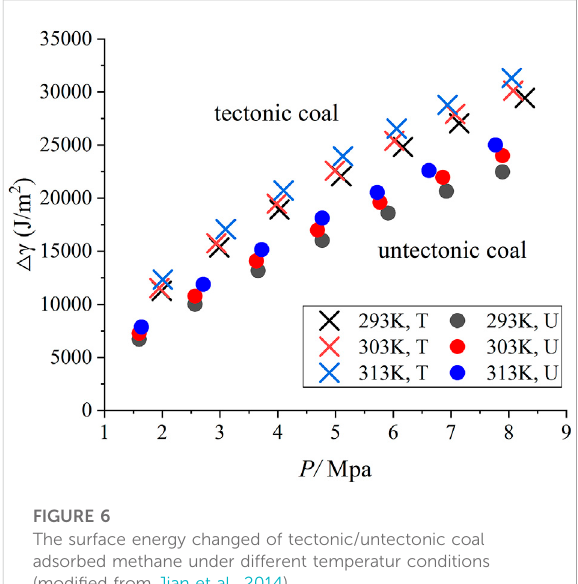
FIGURE 6 The surface energy changed of tectonic/untectonic coal adsorbed methane under different temperatur conditions (modi fi ed from Jian et al.,